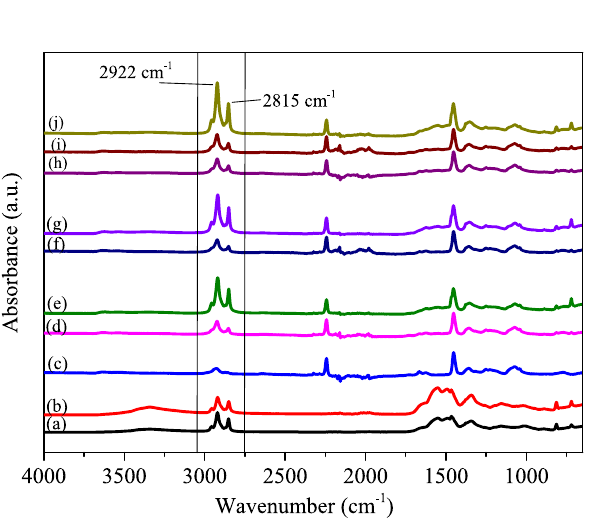
Figure 3. FTIR spectra of ( a ) PCM28; ( b ) PCM32; ( c ) neat PAN; ( d ) PAN-25PCM28; ( e ) PAN-50PCM28; ( f ) PAN-25PCM32; ( g ) PAN-50PCM32; ( h ) PAN-12.5PCM28-12.5PCM32; ( i ) PAN-25PCM28-25PCM32; ( j )